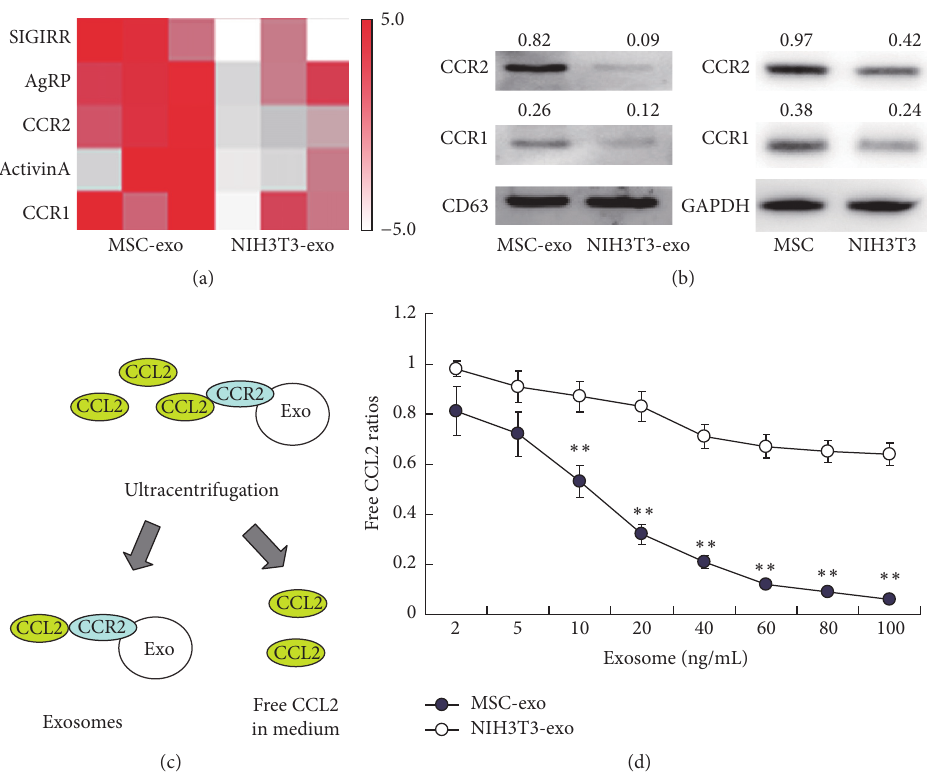
Figure 1: Identification of CCR2 as a key component highly expressed on MSC-derived exosomes (MSC-exo). (a) Screening of specific expressed proteins in bone marrow MSC-derived exosomes (MSC-exo) and NIH3T3 cells-derived exosomes (NIH3T3-exo) by ELISA with three repeat samples in each group. (b) WB analysis of protein expression levels for exosomes and cells. CD63 or GAPDH was used as an internalreferenceproteinforexosomesandcells,respectively.Thegraylevelsofblotswereanalyzedandtheratiosofinterestinggene/reference gene were shown. (c)-(d) Competitive analysis for the binding ability of CCR2 positive exosomes. Recombinant mouse CCL2 protein (100ng per well) was incubated with exosomes in different concentrations for 1 hour. Then these exosomes were removed by ultracentrifugation. The free CCL2 protein levels in the medium were then determined by ELISA analysis and the ratios of free CCL2/total CCL2 were shown (d). Bars represent standard error of the mean ± S.D from three repeats. All the significance was determined by ANOVA and Student’s 𝑡 -test. ∗∗ 𝑃 < 0.01 .